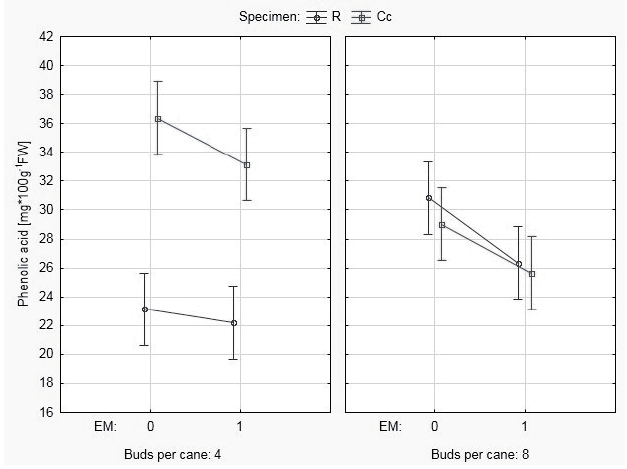
Fig. 3: Effect of the performed treatments on phenolic acid content (in mg 100 g -1 FW) in the fruits of the tested vine cultivars.